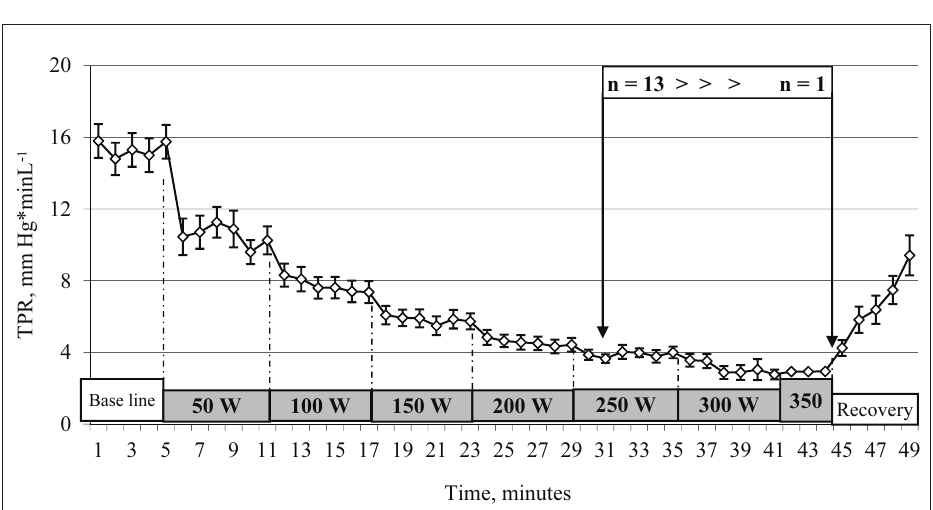
Figure 3. Total peripheral resistance (TPR) changes during incremental exercise